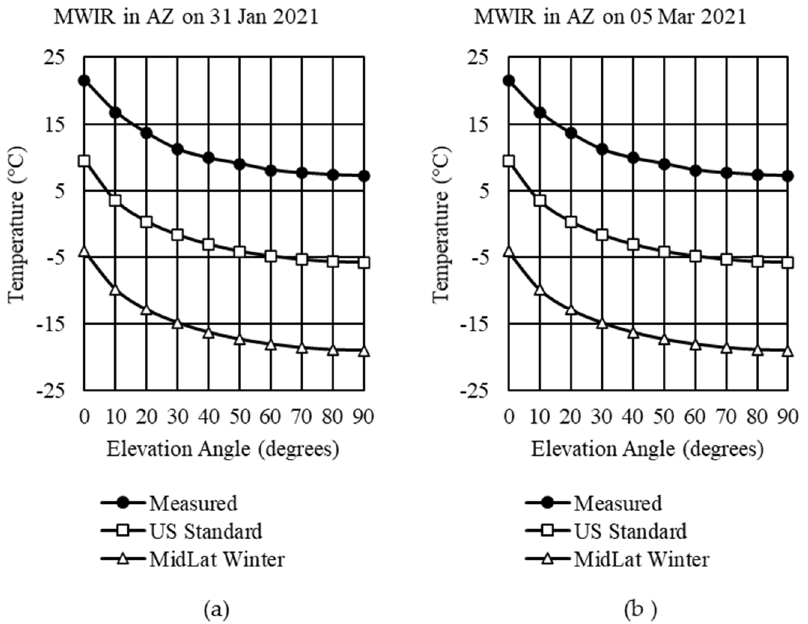
Figure 7. MWIR measured sky temperatures compared US Standard and MidLat winter: ( a )